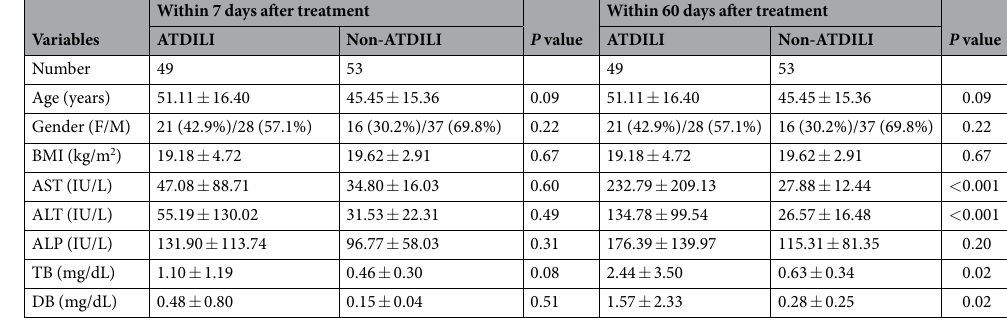
Table 1. Clinical characteristics of tuberculosis patients with and without ATDILI assessed within 7 days and 60 days after commencement of anti-tuberculosis treatment. Abbreviations: ALP, alkaline phosphatase; ALT, alanine aminotransferase; AST, aspartate aminotransferase; ATDILI, anti-tuberculosis drug-induced liver injury; BMI, body mass index; DB, direct bilirubin; F, female; M, male; TB, total